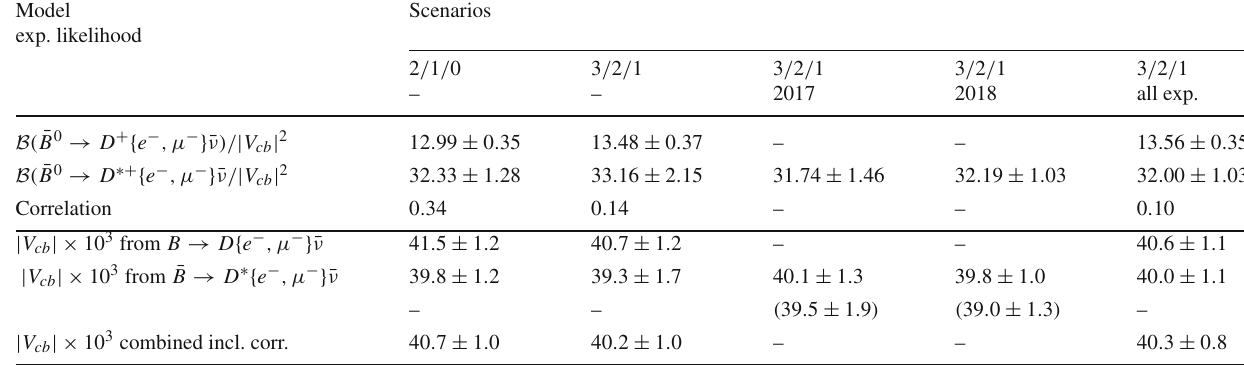
ses are obtained by using only the respective Belle measurements of | 2 , as well as the values of the branching ratios [3,4]. The row for the combined | V cb | takes into cb account correlations in the posterior predictions, but not the small and unpublished correlations in the HFLAV world averages